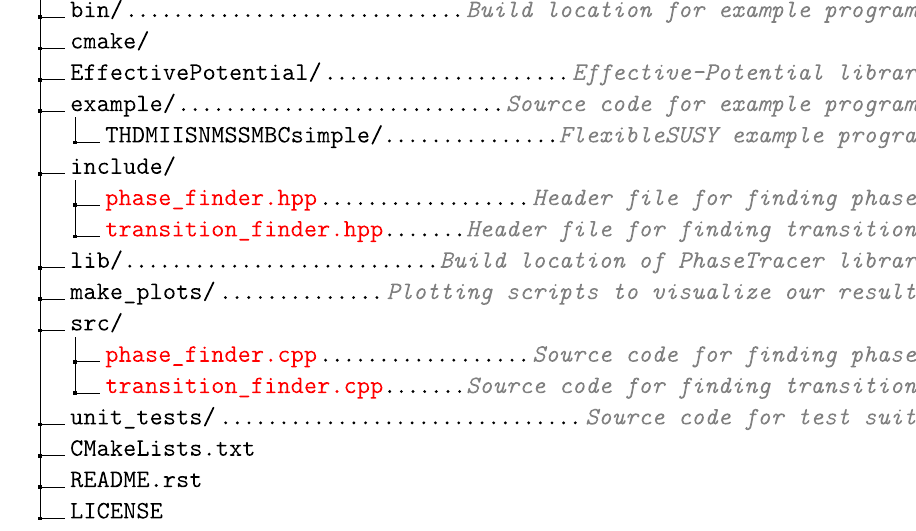
Fig. 1 Outline of the structure of PhaseTracer . We highlight the most important files in red and do not show all